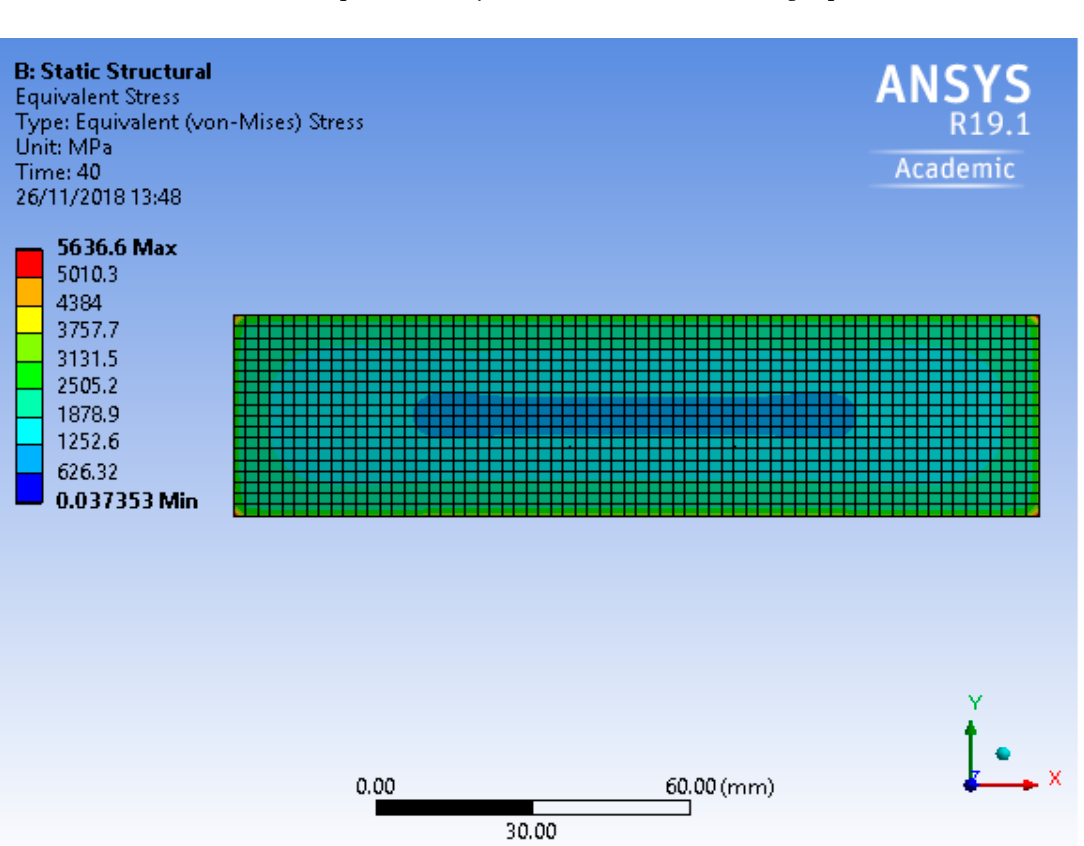
Figure 8. Hot plate showing thermal strain.